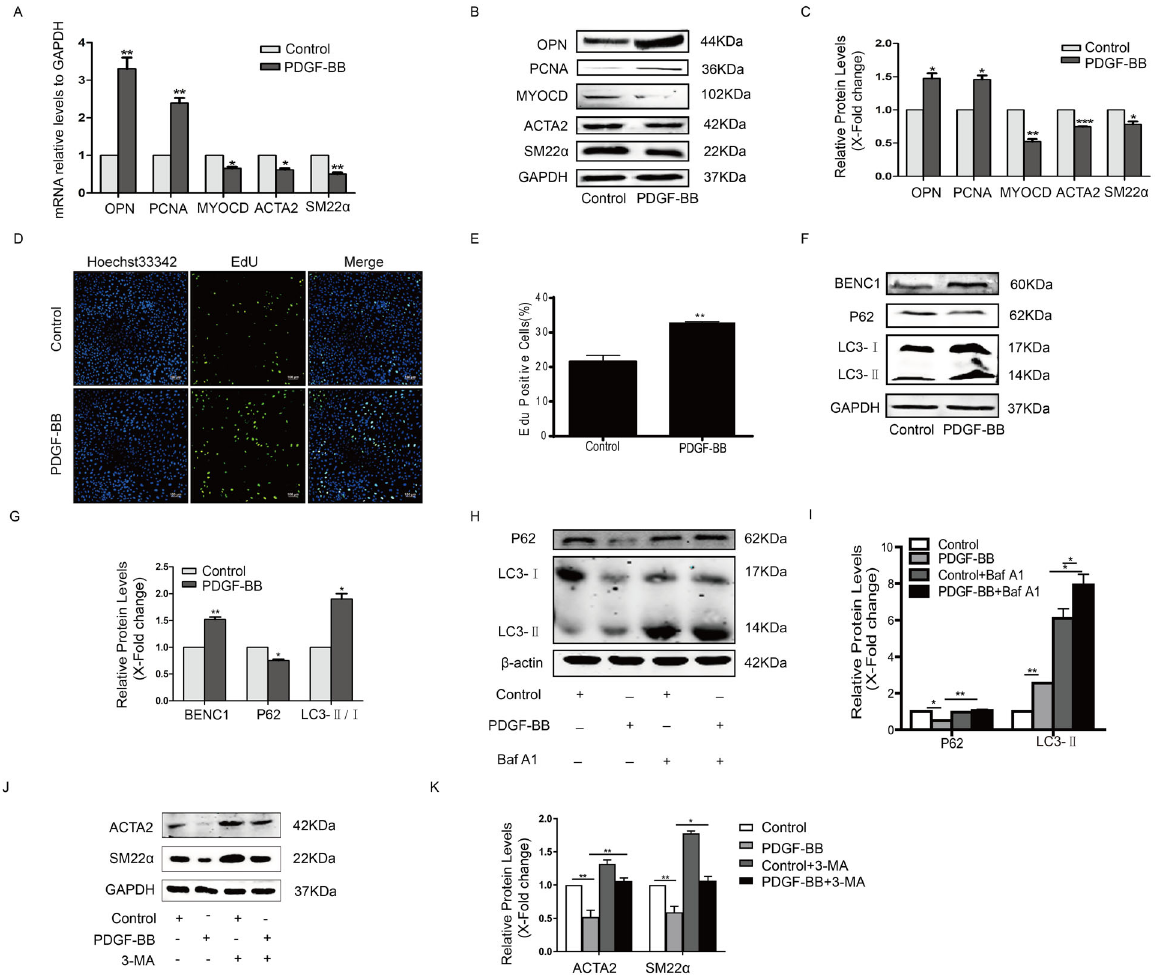
detected by qRT-PCR (* P < 0.05, ** P < 0.01, n = 3). B and C The protein levels of these proliferative markers and contractile genes were detected in HA-VSMCs treated with 40 ng/mL PDGF-BB for 48 h by western blotting (* P < 0.05, ** P < 0.01, *** P < 0.001, n = 3). D and E Cellular proliferation was evaluated in PDGF-BB-stimulated HA-VSMCs by EdU staining (** P < 0.01, n = 3). F and G The expression of beclin1, P62 and LC3 was detected in PDGF-BB-stimulated HA-VSMCs by western blotting (* P < 0.05, ** P < 0.01, n = 3). H and I HA-VSMCs were incubated with PDGF-BB for 24 h and then treated with ba fi lomycin A1 for 2 h. Cells were harvested and accumulation of P62 and LC3 was measured by western blotting (* P < 0.05,* P < 0.01, n = 3). J and K Serum-starved HA-VSMCs were pretreated with 5 mM 3-MA for half an hour and then incubated with 40 ng/mL PDGF-BB for another 48 h. Western blot images and quanti fi cation in each group are shown (* P < 0.05, ** P < 0.01, n =